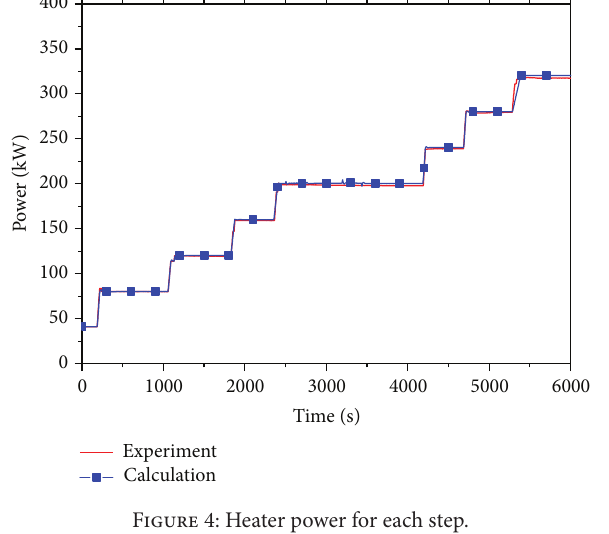
Figure 6: Primary system mass flow rate.